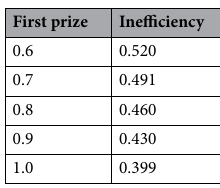
Table 1. Inefficiency of Noiseless 3-Bidder